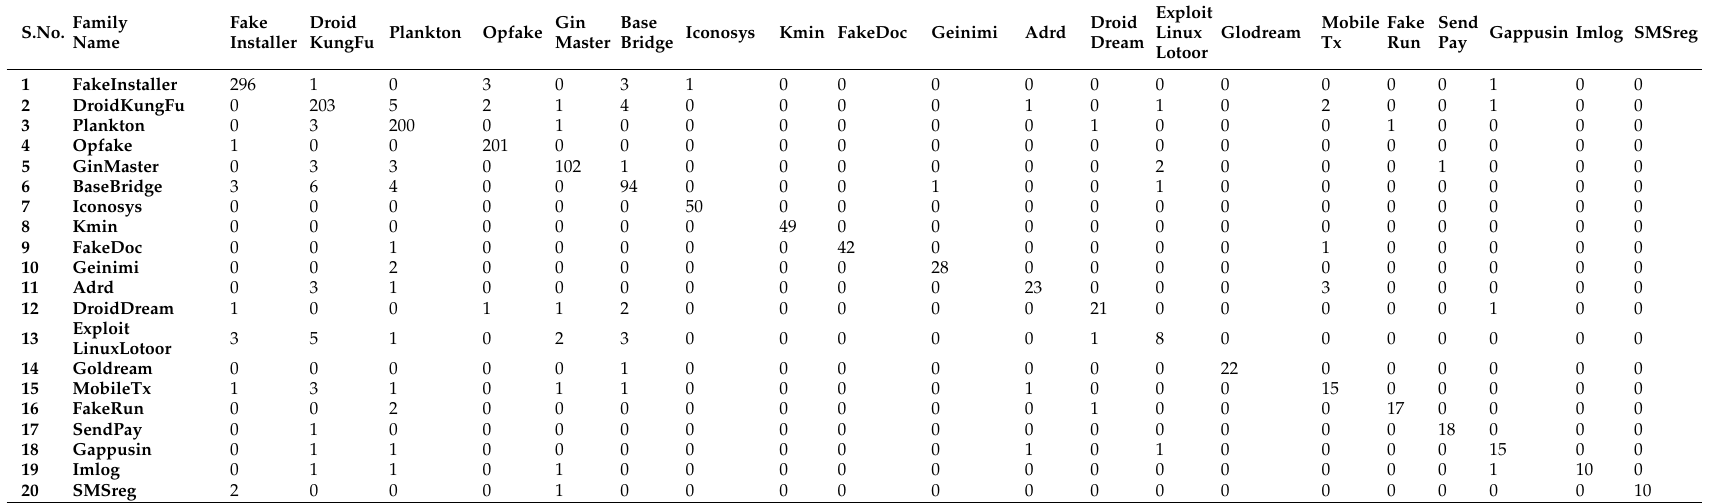
Table 7. A confusion matrix of top 20 malware